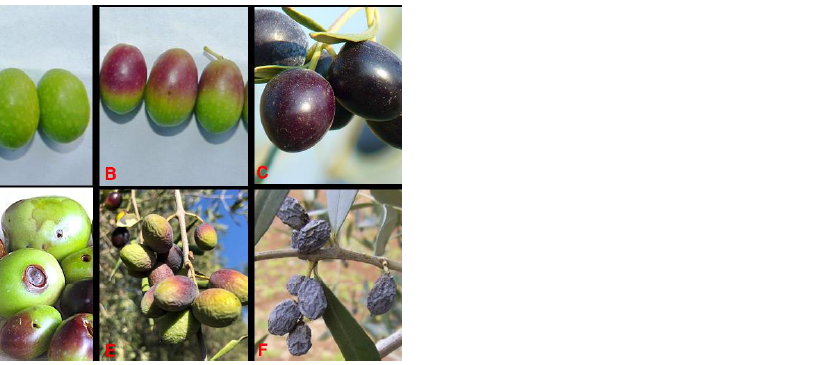
Figure 1. ( A ) “Top Green;” ( B ) “Good Green;” ( C ) “Good Black;” ( D , E ) “Bad Green;” ( F ) “Bad Black”.